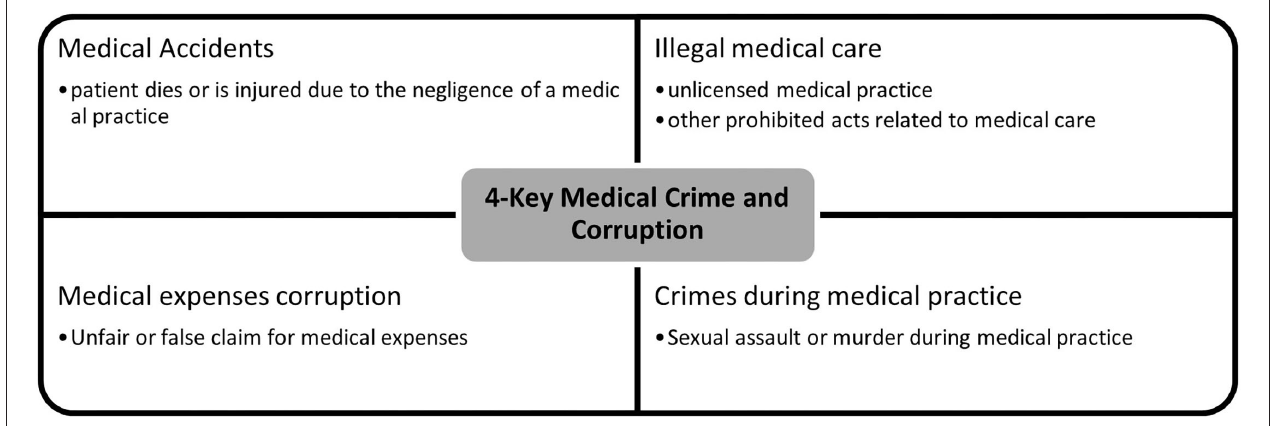
FIGURE 1 | 4-Key Medical Crime and